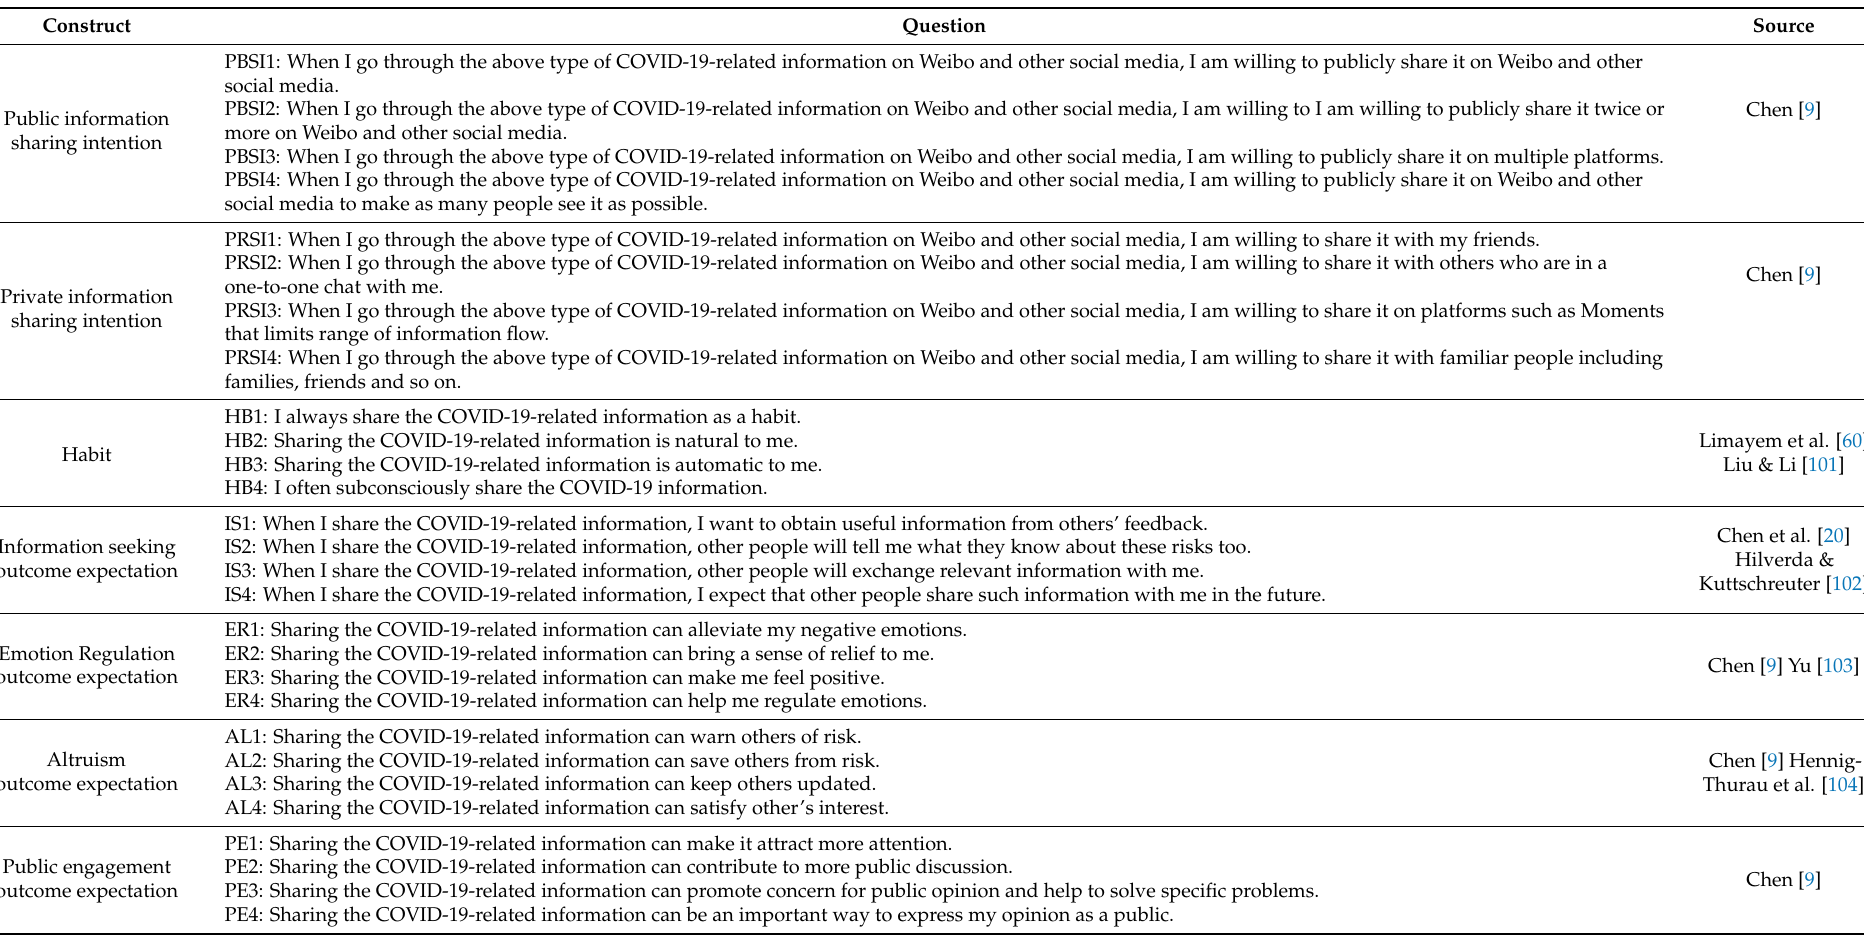
Table 1. Measurement of